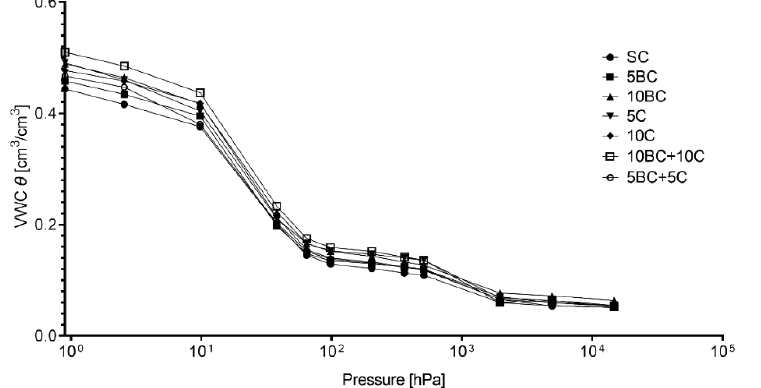
Figure 2. Water retention curves for experimental treatments. VWC, volumetric water content. Abbreviations of the treatments are defined in Table 3.